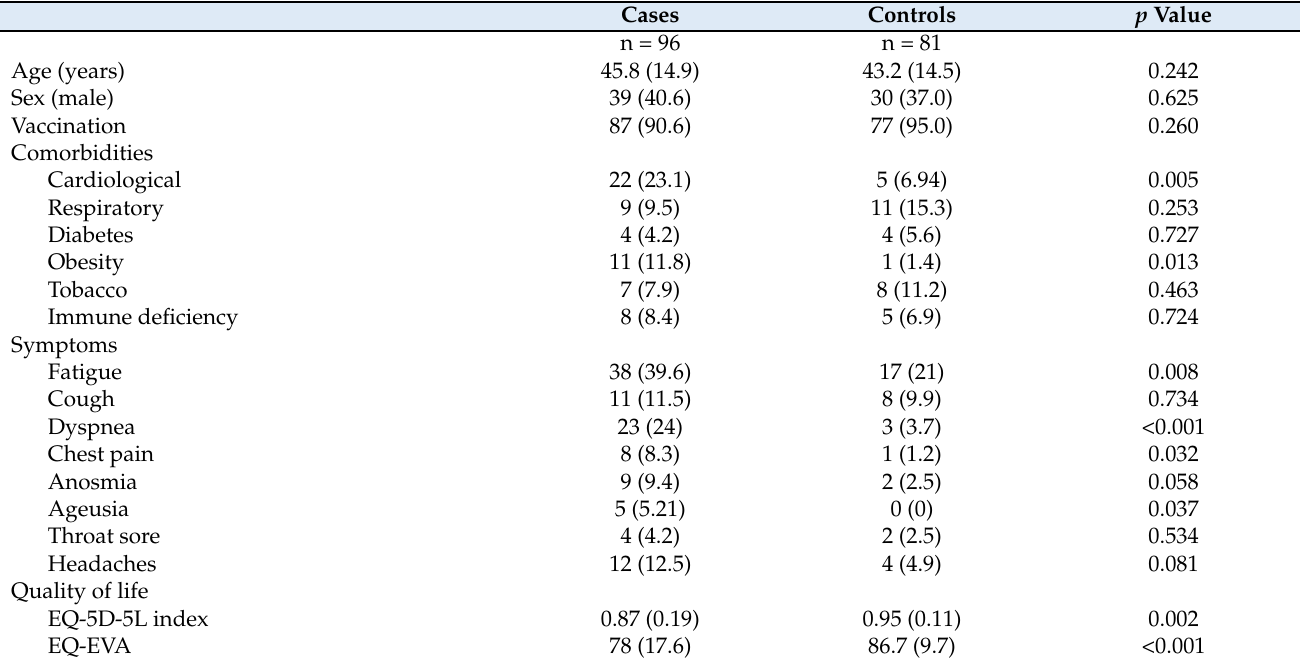
Table 1. Symptoms and quality of life of 177 patients at 1 year after their visit in a COVID ambula- tory center.